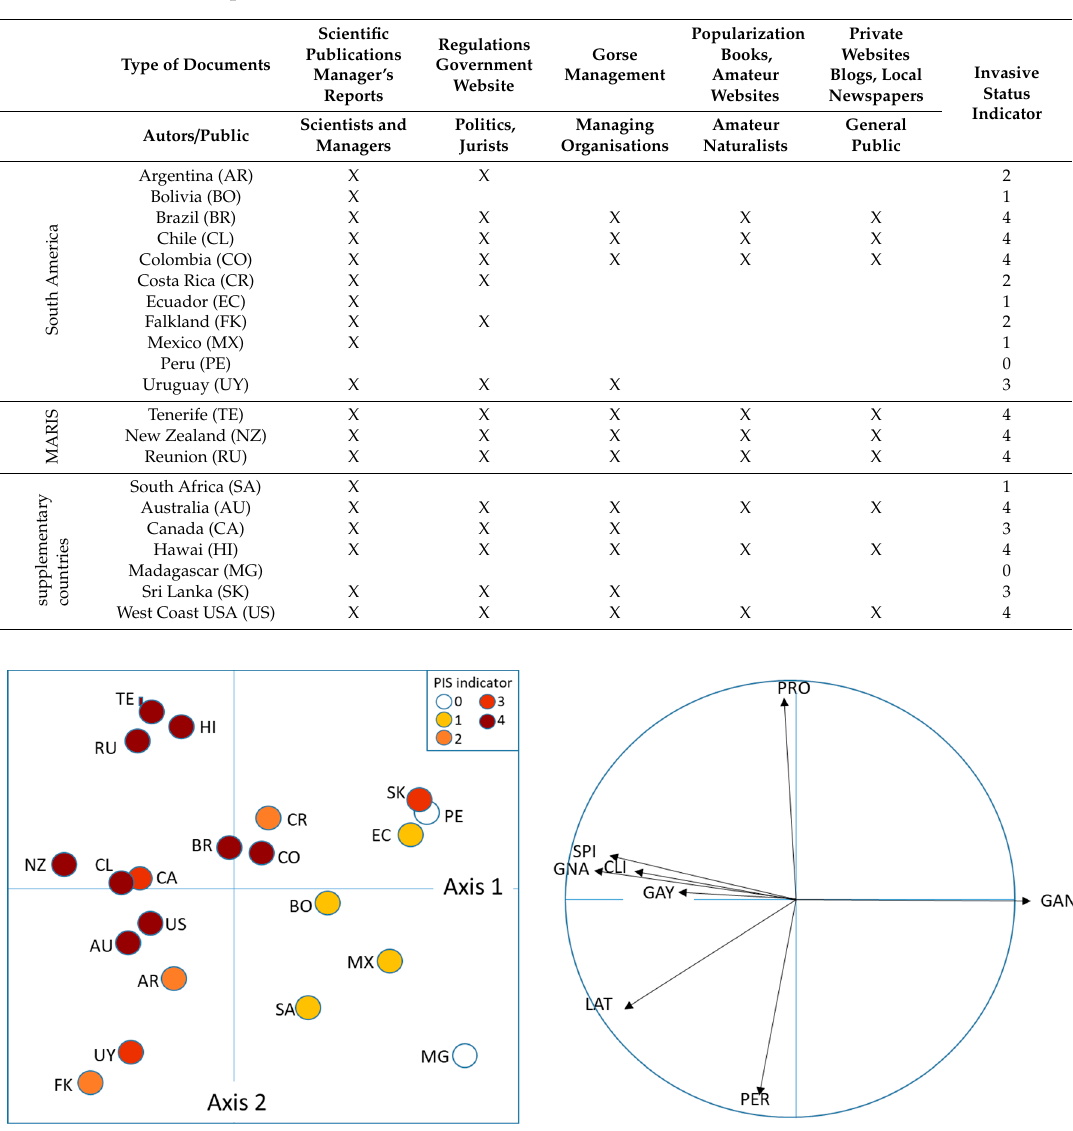
Table 3. Type of documents where the invasive status of gorse is publicized and corresponding level of the indicator of the publicization of the invasive status.